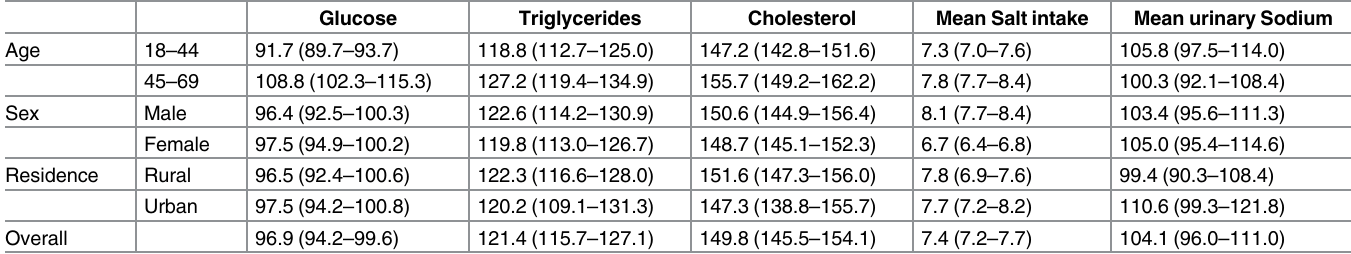
Table 4. Means (confidence intervals) of different biochemical parameters in population of Punjab State, 2014 –